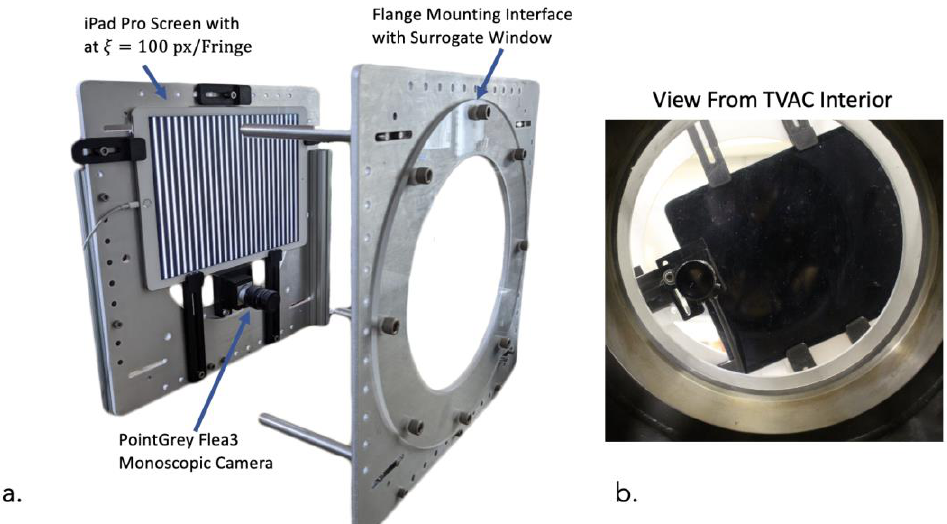
Figure 6. The mechanical deflectometer frame consists of two 356 mm × 356 mm aluminum plates with mounting holes to allow flexible mounting for a camera and illumination screen ( a ). Standoffs fastened through aluminum slots allow for longitudinal adjustment. The plates were fastened to existing 3/8” bolts. The deflectometer assembly was rotated 22 degrees about the window normal in order to match the orientation of the in-situ bolt hole pattern ( b ). A design choice of 100 pixels per black/white fringe, 7-step phase shifts, and 3 averages per shot was optimized on-site. Outside the chamber volume, a vacuum inflation control unit provided by FreeFall